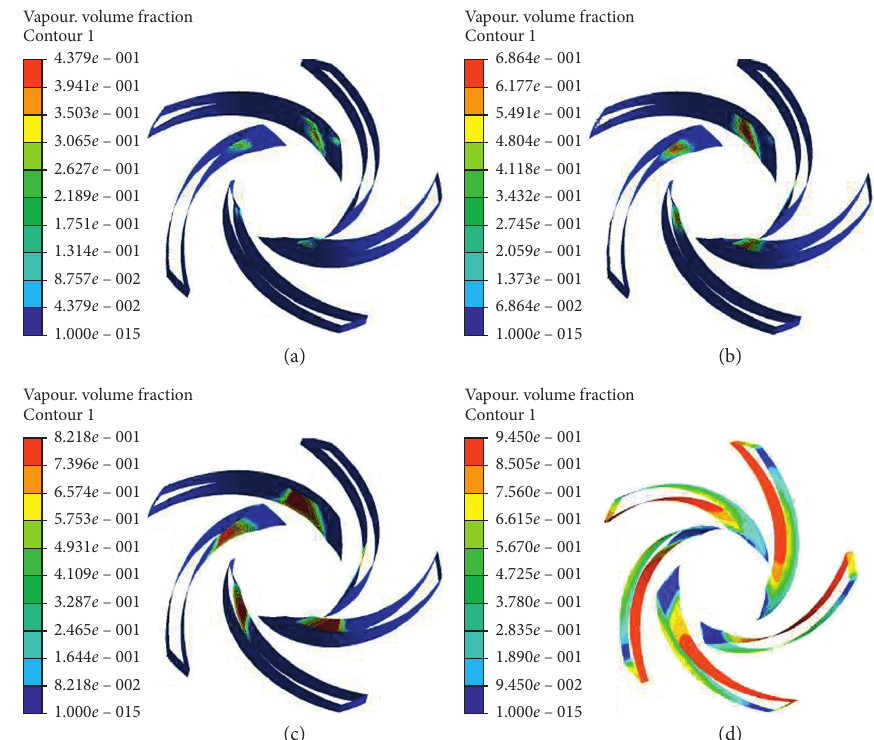
1Vapour. volume fraction Contour